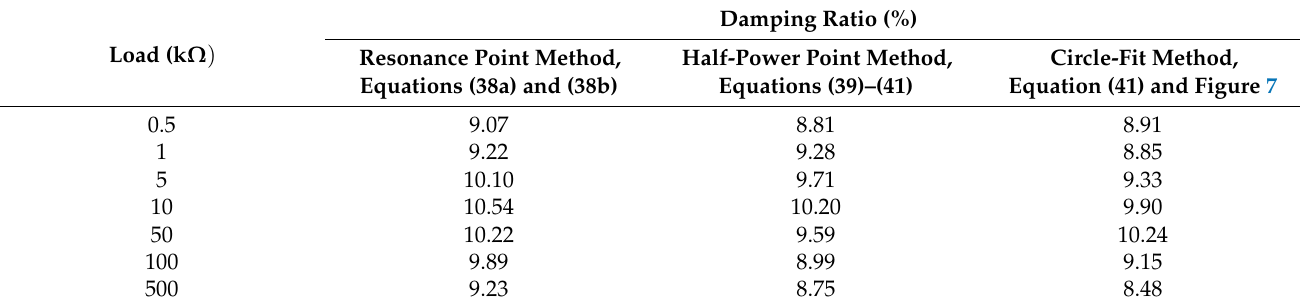
Table 4. Estimates of damping ratio from transmissibility FRF (experiment) using three different